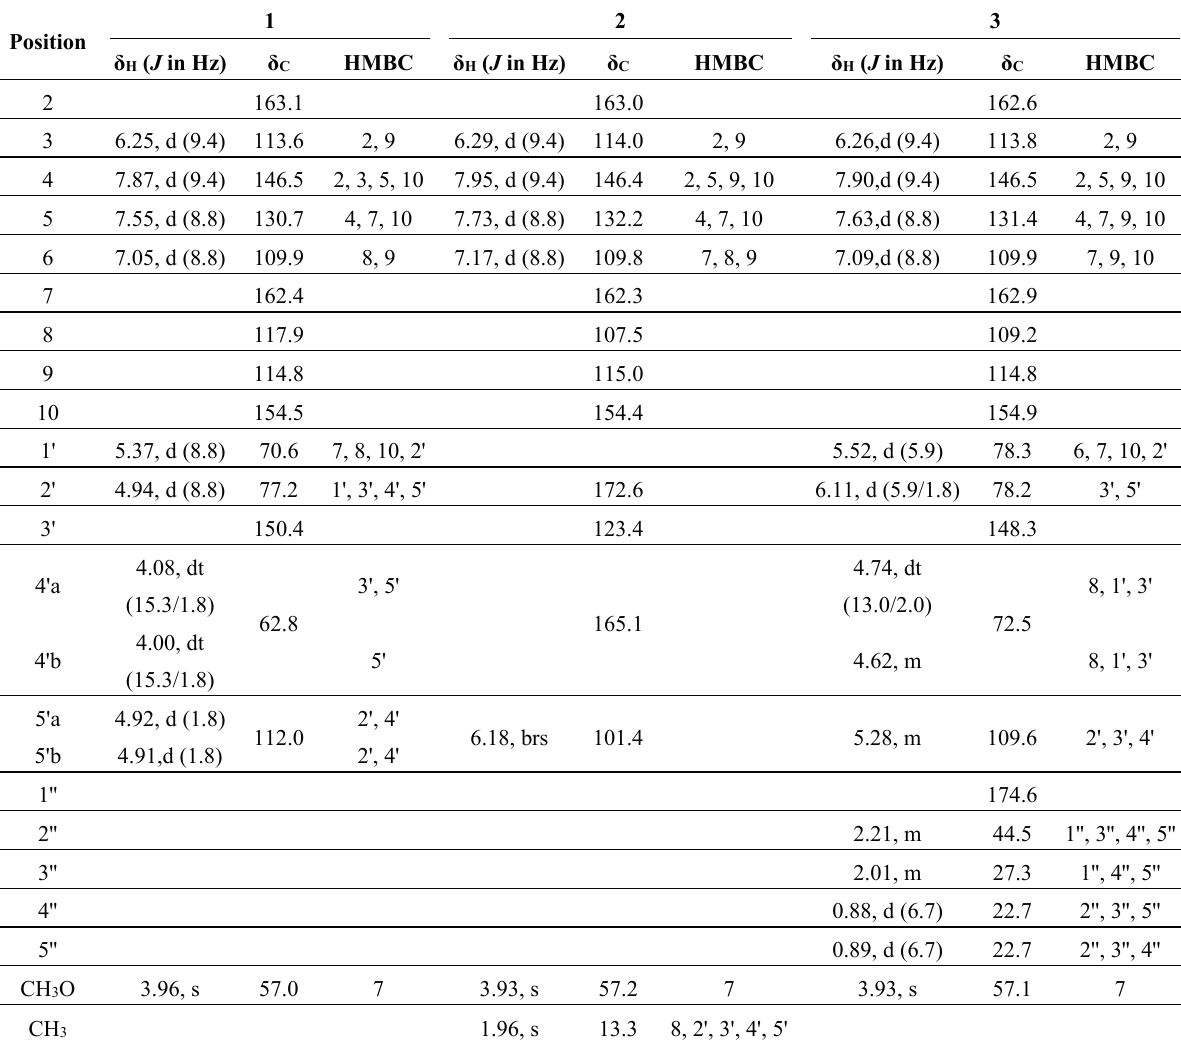
Table 2. NMR Spectroscopic Data (600 MHz, CD 3 OH) for compounds 1 – 3